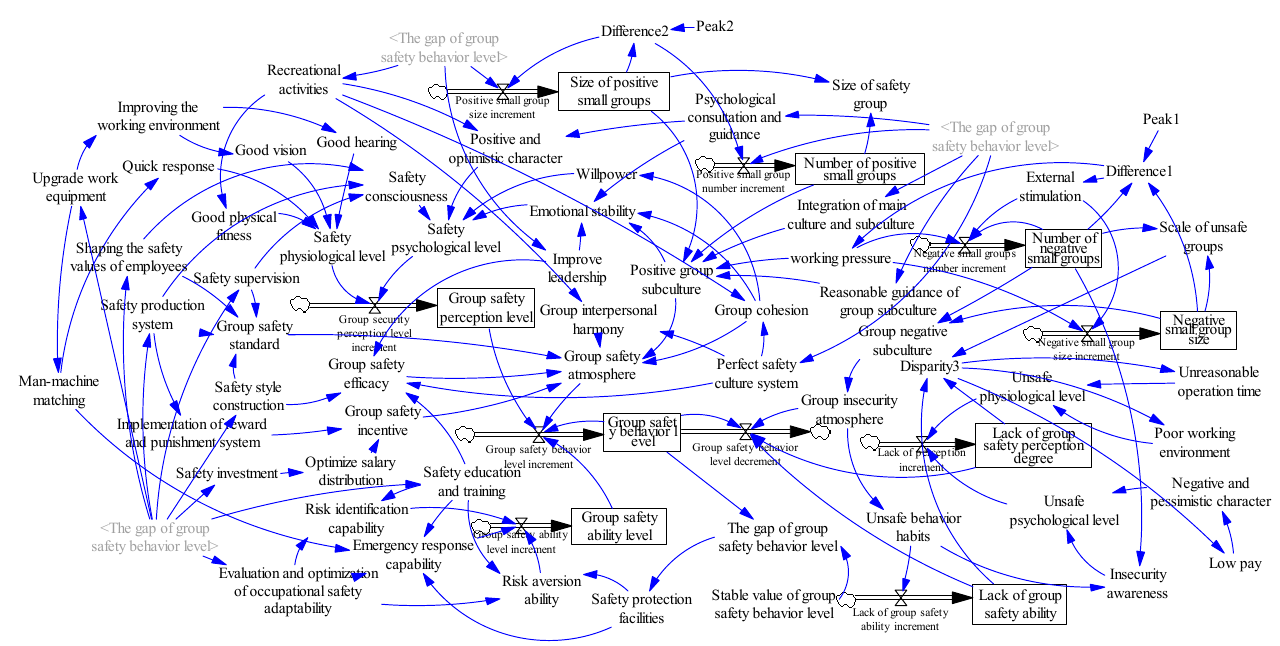
Figure 1. SD flow chart of the level of safety behavior of coal mine workers. Table 1. Data table of initial values of some variables in SD